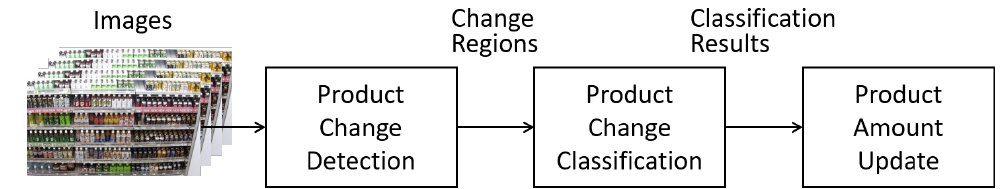
Figure 2. Process flow of proposed